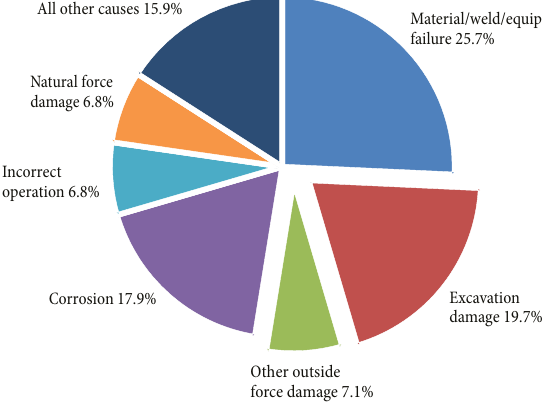
Fig. 2. Classification of the causes of incidents at pipelines in United States